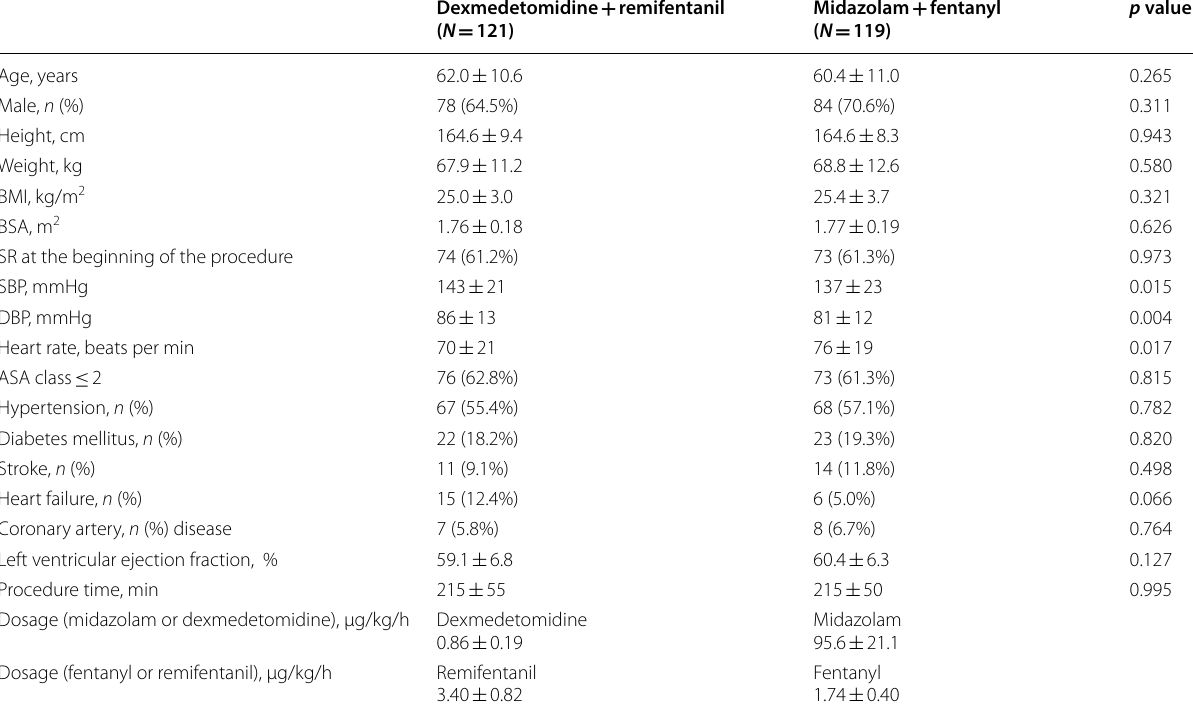
Categorical variables are presented as frequency with percentages (%) and continuous variables are presented as mean